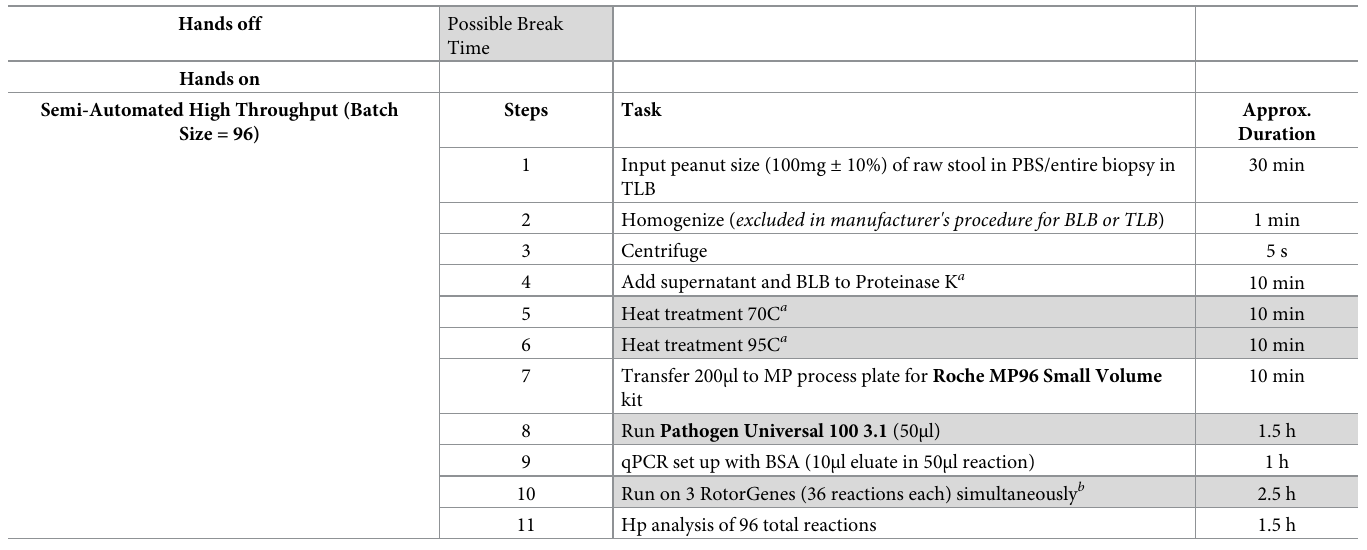
Table 1. Duration time for each step of the high throughput, 96-well plate workflow. Hands